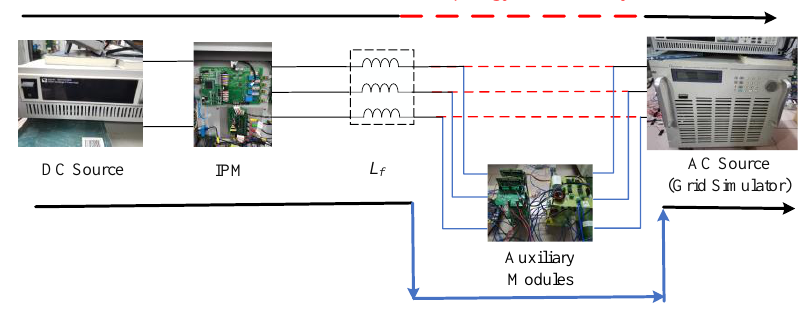
Figure 13. Configuration of the experimental setup.